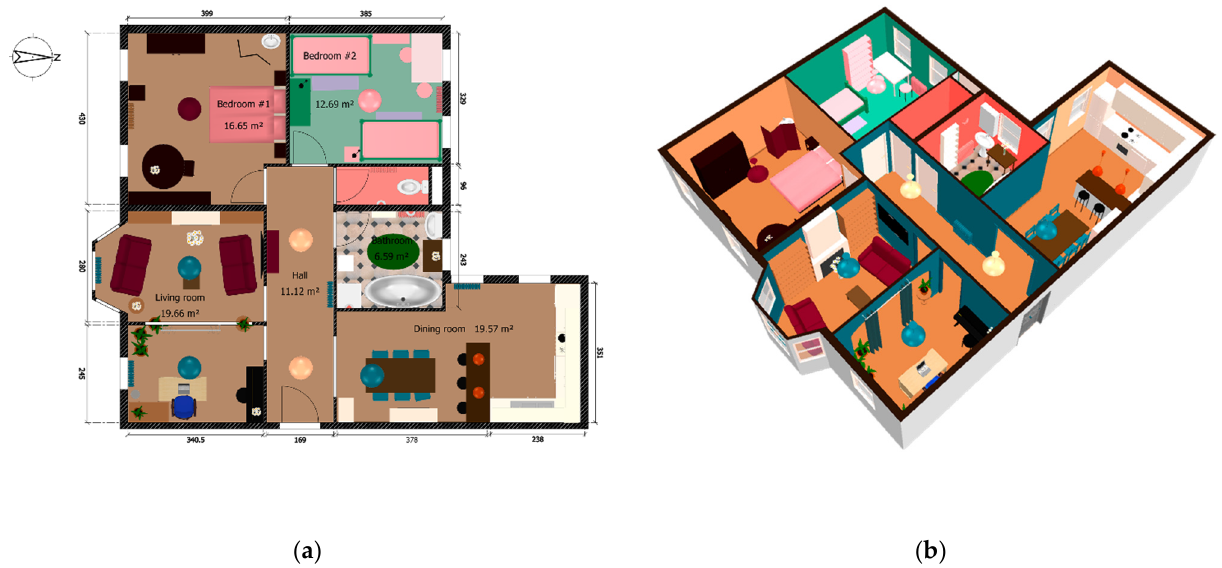
Figure 13. Distribution of the apartment furniture proposed by the designer: ( a ) 2D and ( b ) 3D plan of the apartment with the furniture included.